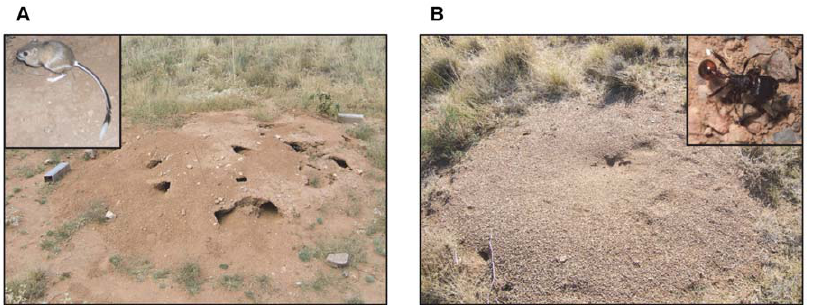
Figure 1. Representative structures built by banner-tailed kangaroo rats and rough harvester ants. Banner-tailed kangaroo rats build raised burrow systems called mounds (A) and rough harvester ant colonies build a cleared surface disc (B) over their underground nests. For scale, the live traps next to the mound are 30.5 cm long, whereas the colony disc is approximately 1 m in diameter.